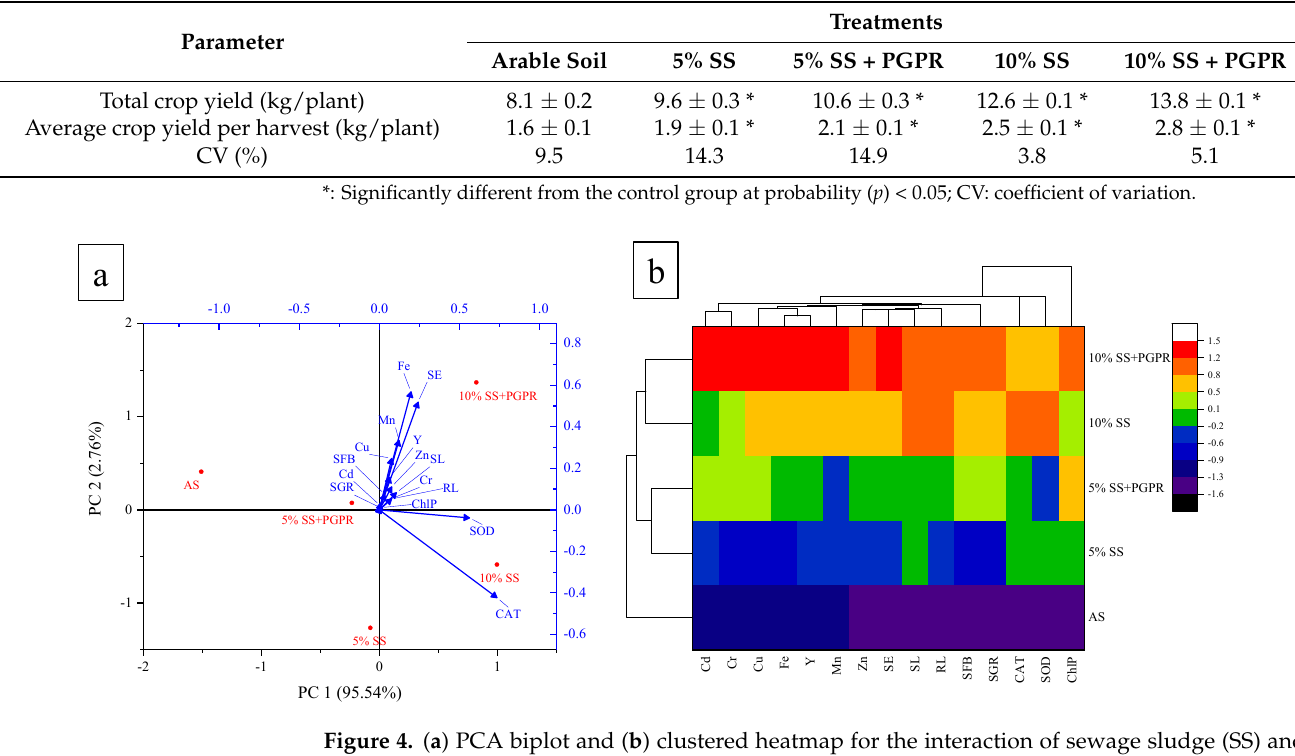
Figure 4. ( a ) PCA biplot and ( b ) clustered heatmap for the interaction of sewage sludge (SS) and plant growth-promoting rhizobia (PGPR) on metal element contents and biochemical response of Ridge gourd ( L. acutangula ).